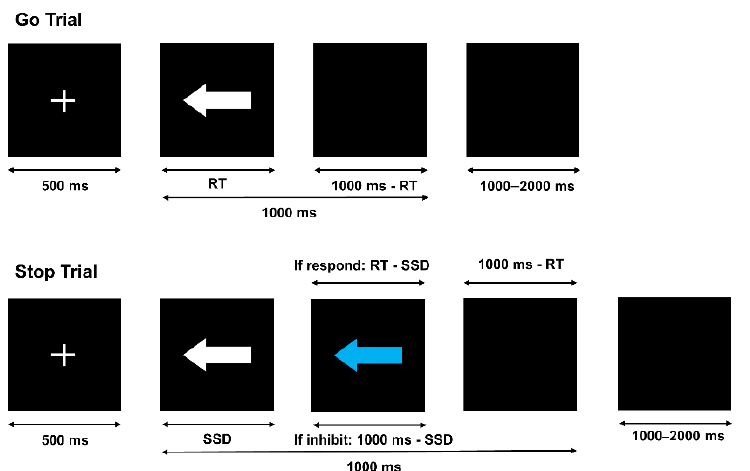
right) and press the corresponding button as accurately and quickly as possible (RT is the response